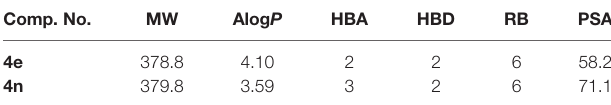
TABLE 3 | Calculated physico-chemical properties of the most active compounds, 4e and 4n . Comp. No.